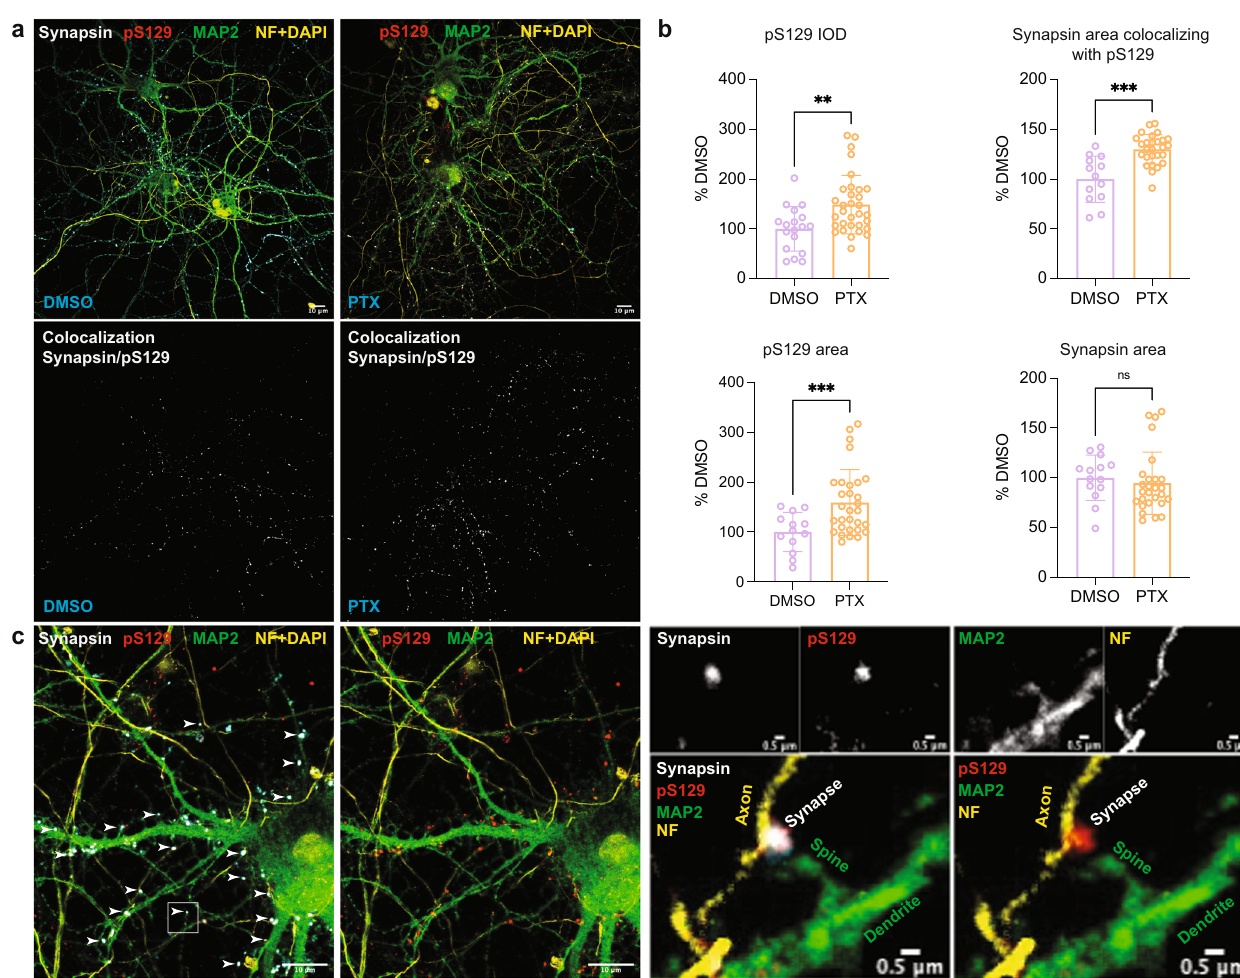
Fig. 5 Increased pS129 signal and localization in synapsin-containing boutons after PTX stimulation. a Representative images of synapsin/ pS129 colocalization in DIV18 rat cortical neurons treated with DMSO vs. 20 µM PTX. Top images: synapsin, pS129, MAP2, and neuro fi lament (NF) + DAPI staining. DMSO control on the left, PTX treatment on the right. Bottom images: colocalization mask synapsin/pS129. DMSO control on the left, PTX treatment on the right. Scale bar, 10 μ m. b Quanti fi cations (DMSO vs. PTX). Top left, pS129 integrated optical density (IOD). Quanti fi cation of N = 14 images for DMSO; N = 30 images for PTX. Top right, synapsin area colocalizing with pS129. N = 13 images for DMSO; N = 29 images for PTX. Bottom left, pS129 area. N = 13 images for DMSO; N = 30 images for PTX. Bottom right, synapsin area. N =